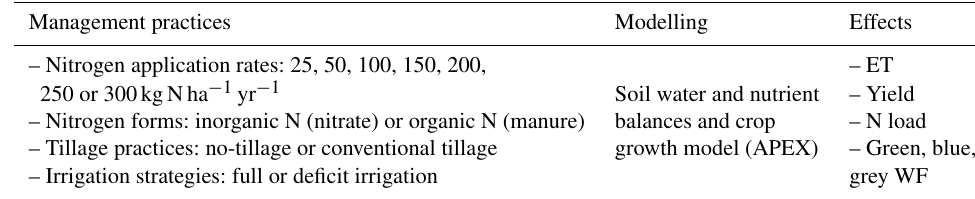
Table 1. Research set-up: the APEX model is used to simulate the effect of 56 management packages (combinations of different management practices) on ET; crop yield; nitrogen load to fresh water; and green, blue and grey